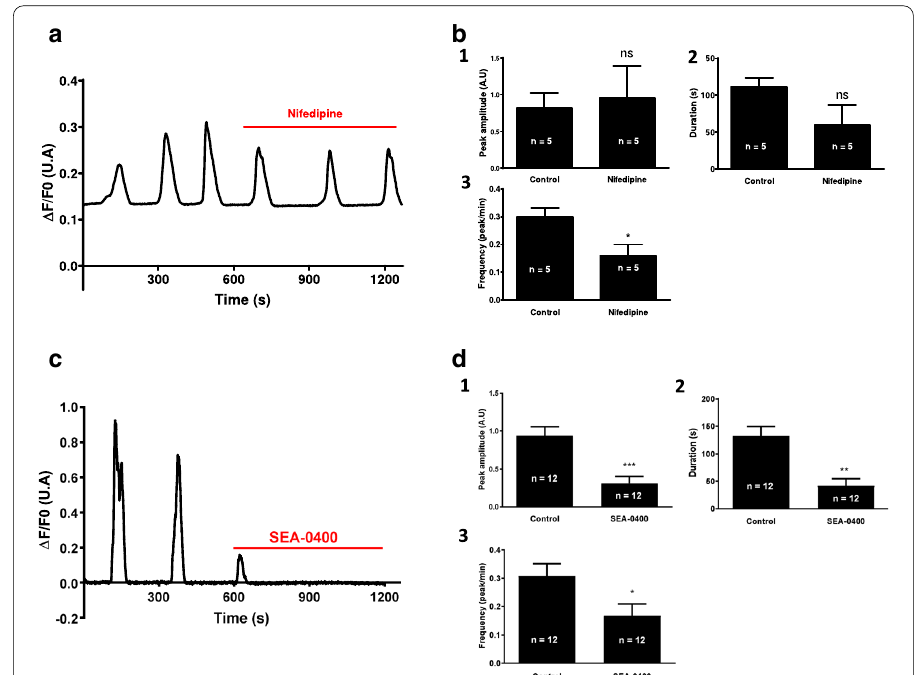
Fig. 4 Role of L‑type calcium channel and NCX exchanger activity in W8B2 + CSCs after 28 days of in vitro differentiation. a Effect of 5 µM nifedipine (L‑type CaV inhibitor) and c 3 µM SEA‑0400 (NCX exchanger inhibitor) on spontaneous calcium activity recorded in differentiated CSCs. Graphs illustrate variations in [Ca 2 + ] i as represented by changes in the ΔF/F0 ratio. ΔF F F0 (F: fluorescence emitted by CaMP at a given = − time; F0: basal fluorescence emitted by GCaMP). Bar graphs (1), (2), (3) represent the evolution of the peak amplitude, the duration and frequency of calcium oscillations, respectively, recorded from differentiated W8B2 + CSCs after treatment with nifedipine (5 µM) ( b ) and SEA (3 µM) ( d ). (N 3 patients, n: represents = the number of events (oscillations) recorded, AU: arbitrary unit, ns: not significant). *p < 0.05, **p < 0.01, ***p < 0.001 vs. control; t‑test paired followed by a Wilcoxon